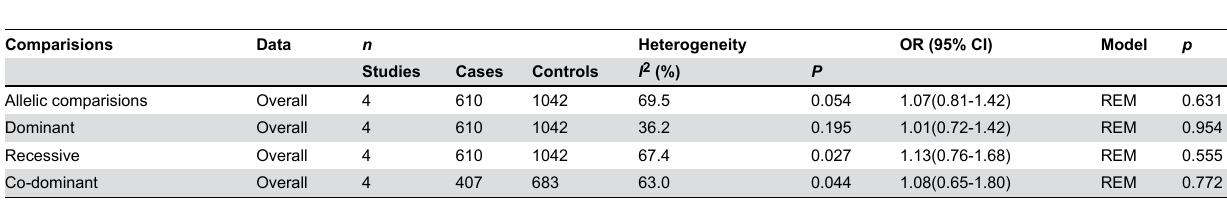
Table 5. Pooled measures for the association between the PAI-1 -675 4G/5G polymorphism and susceptibility to diabetic coronary heart diseases.